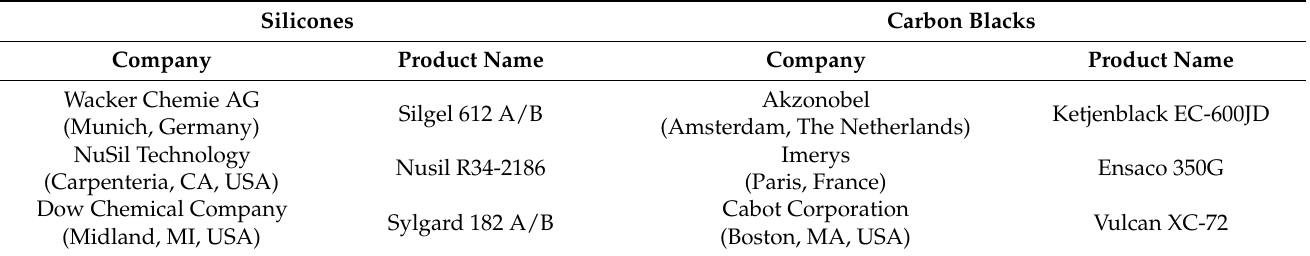
Table 1. Company and product names of the used silicones (left) and the used carbon blacks (right). Silicones